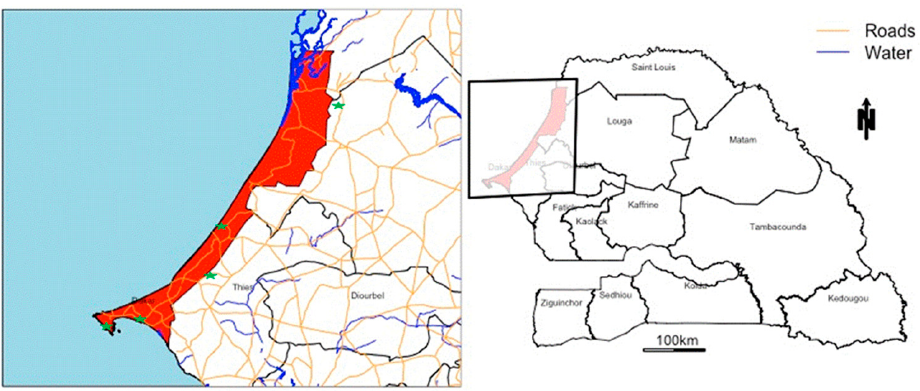
Figure 1. Localization of the Niayes zone (red) and cities (green stars) where vegetable sampling was